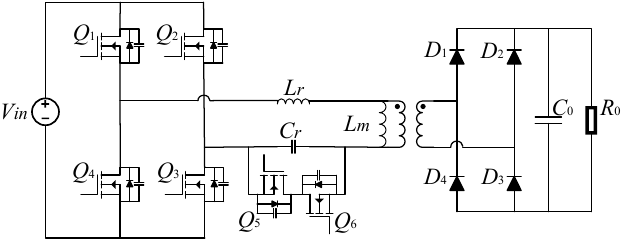
Figure 3. A novel LSCC converter.